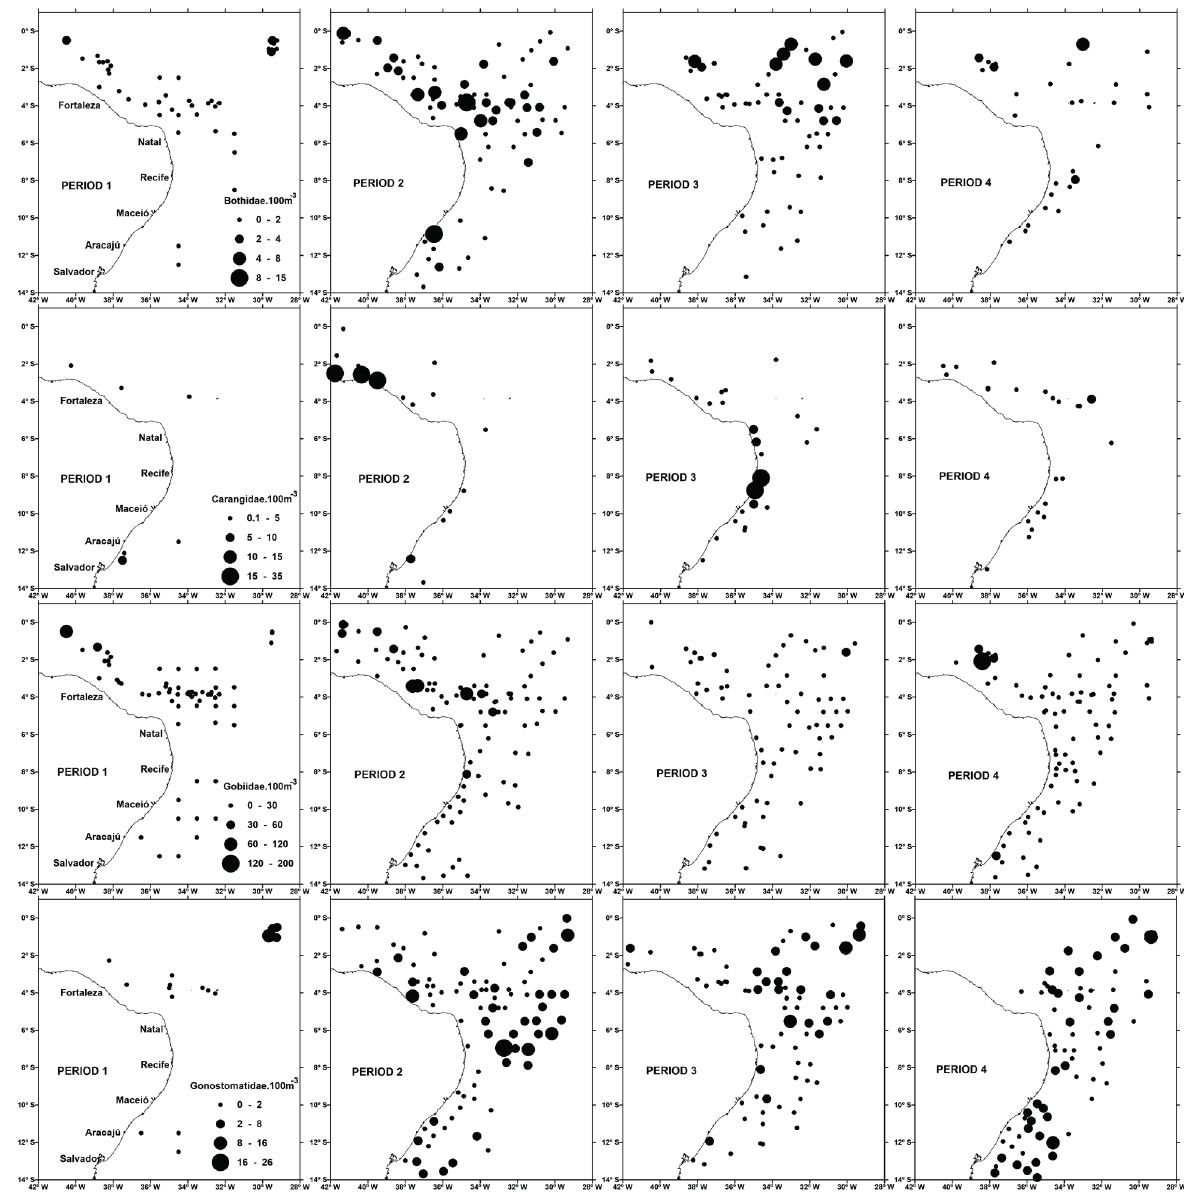
Figure 5 - Distribution and density (larvae.100m -3 ) of the fish larvae families (Bothidae, Carangidae, Gobiidae and Gonostomatidae) in the west tropical Atlantic